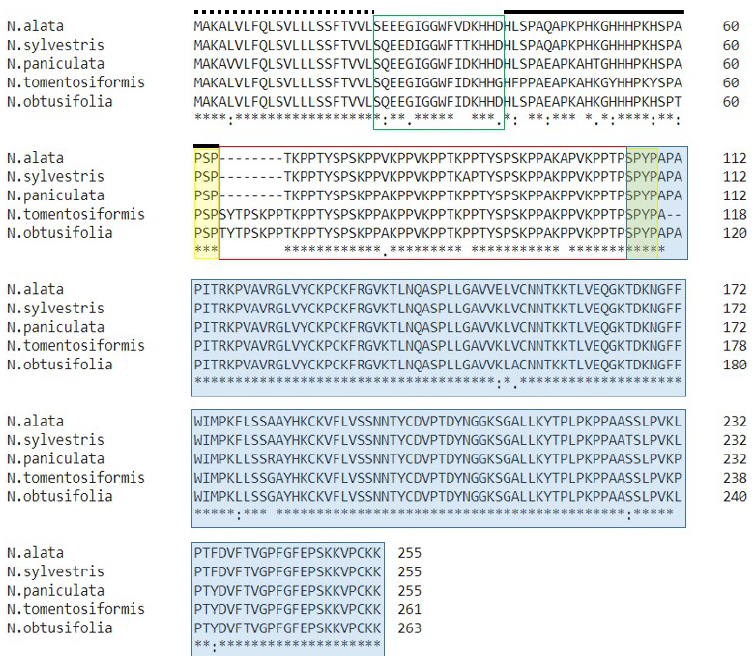
Figure 6. Multiple alignments of HD-AGP protein sequences from Nicotiana alata ( Na PRP4), N. sylvestris ( Ns PRP1), N. paniculata ( Np PRP1), N. tomentosiformis ( Nto PRP1) and N. obtusifolia ( Nob PRP1). The signal peptide sequence is shown with a dotted line above; the two hypervariable domains, HVI and HV2, are